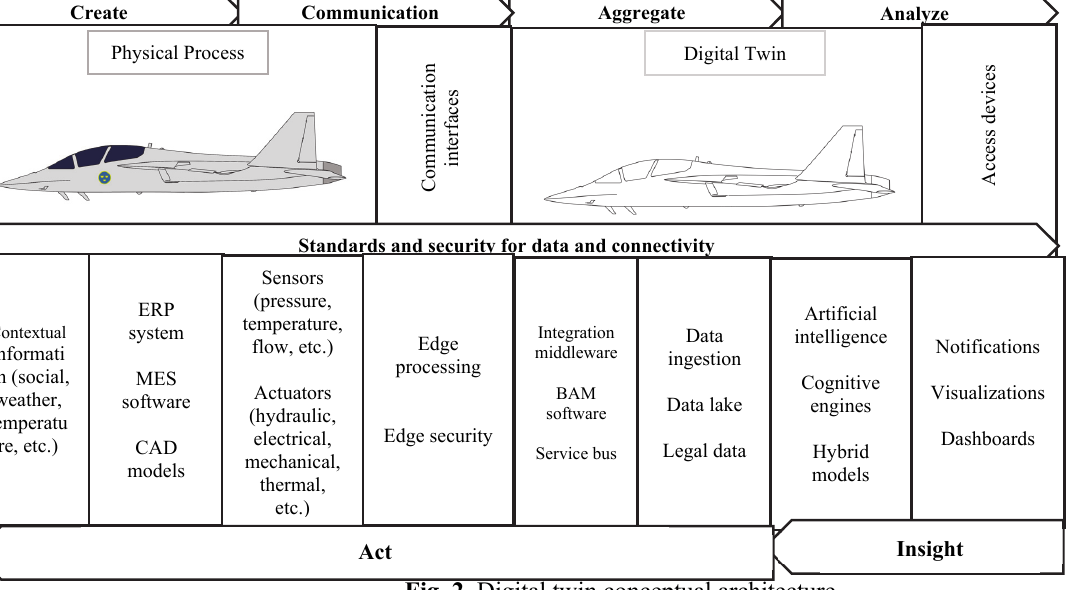
Fig. 2. Digital twin conceptual architecture